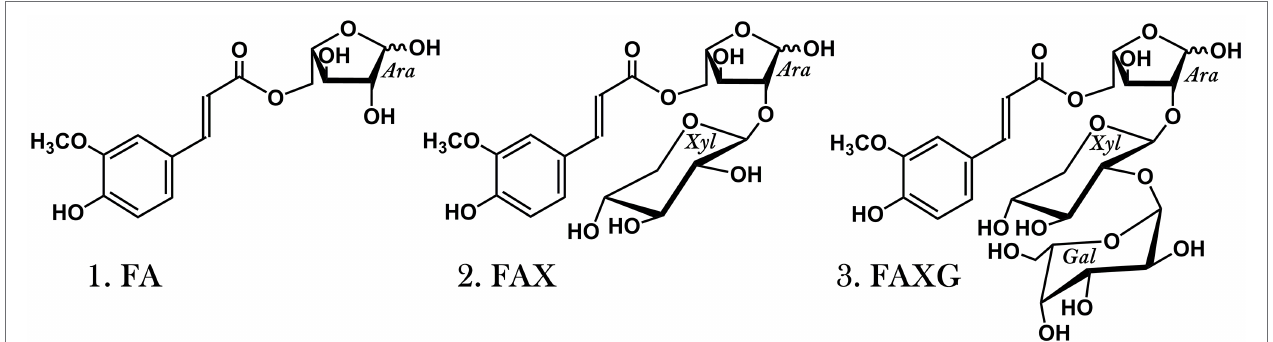
FIGURE 1 | Feruloylated side chain standard compounds released from maize arabinoxylan via mildly acidic hydrolysis, purified, and used for method development. 1. FA: 5- O - trans -feruloyl- l -arabinofuranose. 2. FAX: β - d -xylopyranosyl-(1 → 2)-5- O - trans -feruloyl- l -arabinofuranose. 3. FAXG: α - l - galactopyranosyl-(1 → 2)- β - d -xylopyranosyl-(1 → 2)-5- O - trans -feruloyl- l